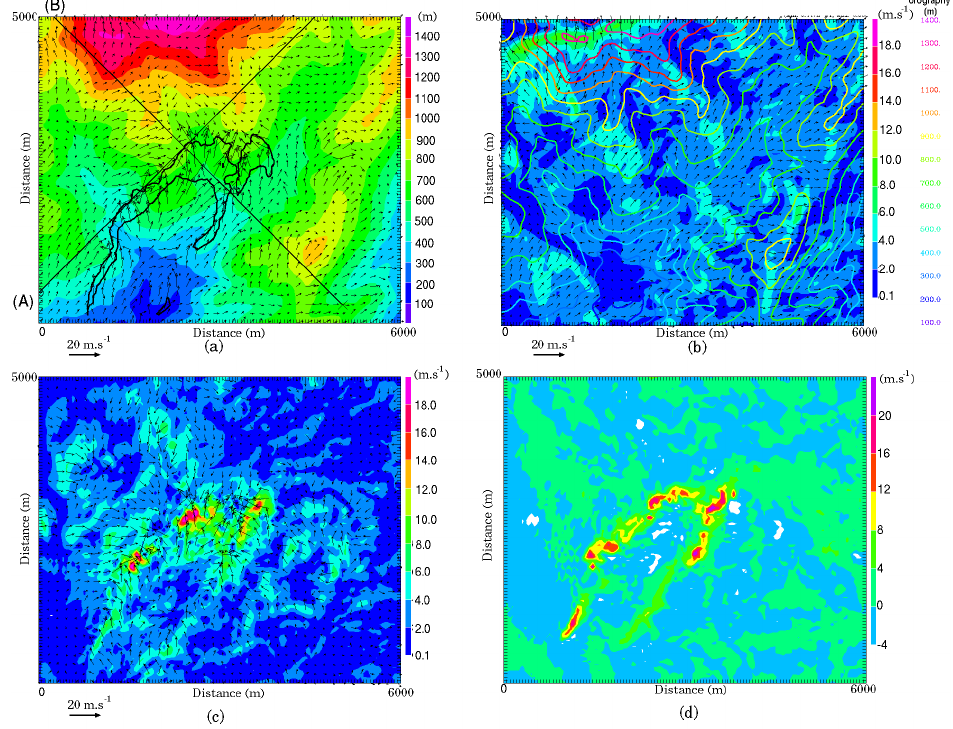
Figure 8. Horizontal cross-sections on 23 July 2009 at 1500 UTC: ( a ) envelop of the fire front (in black) at the ground superimposed on the 10-m wind vectors (arrows) of the “coupled” simulation and on the orography (color, in m) with the axis of the vertical cross-sections; ( b , c ) 10-m wind speed (in ms − 1 ) with wind vectors superimposed for the ( b ) “uncoupled” and ( c ) difference “coupled minus uncoupled” simulations; ( d ) Vertical velocity at a 300-m height (in ms − 1 ) for the difference “coupled minus uncoupled” simulations. Orography isocontours are superimposed in ( b